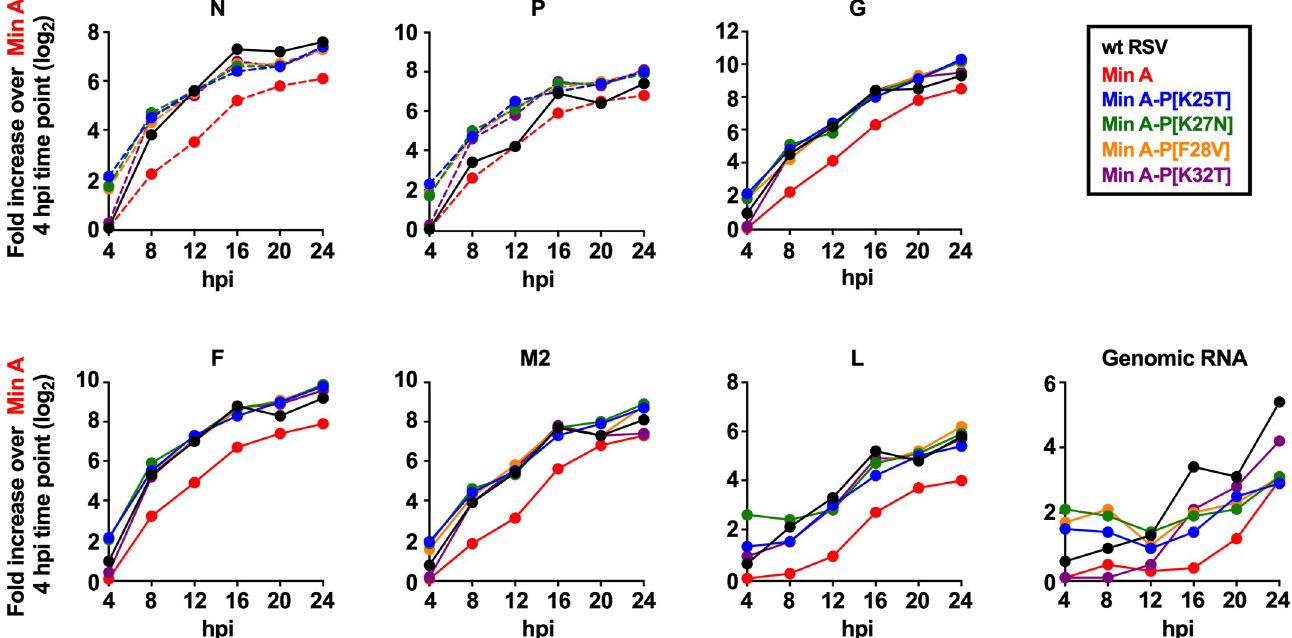
Fig 3. The P mutations restored RNA synthesis by Min A during a single-cycle infection. Replicate cultures of Vero cells were infected at an MOI of three PFU/cell with the indicated viruses at 37˚C. Cell-associated RNA was collected every four h from four hpi to 24 hpi. Positive-sense RSV RNAs (mRNAs and antigenome) were quantified in triplicate by strand-specific RT-qPCR with tagged primers. Note that the CPD ORFs were sufficiently different in sequence from wt that they required the use of separate primers and probes. Data specific to the wt and CPD ORFs are shown with solid and dashed lines, respectively. Thus, expression of the CPD N and P ORFs of the Min A-derived viruses shown here cannot be directly compared to the N and P ORFs of wt RSV, whereas the other ORFs shown here [G, F, M2-1, and L] were wt in all viruses and thus can be compared directly between Min A-derived viruses and wt RSV. Negative-sense (i.e., genomic) RNA was detected by strand-specific RT-qPCR with tagged primers and a probe specific to the M2-1 ORF (solid lines). Data were normalized to 18S ribosomal (r)RNA and expressed as fold increase over Min A at the four hpi time point with the exception of N and P of wt RSV, which were expressed as fold- increase over wt RSV at the four hpi time point. Data for the remaining CPD genes (NS1, NS2, M, and SH) are shown in S1 Fig.